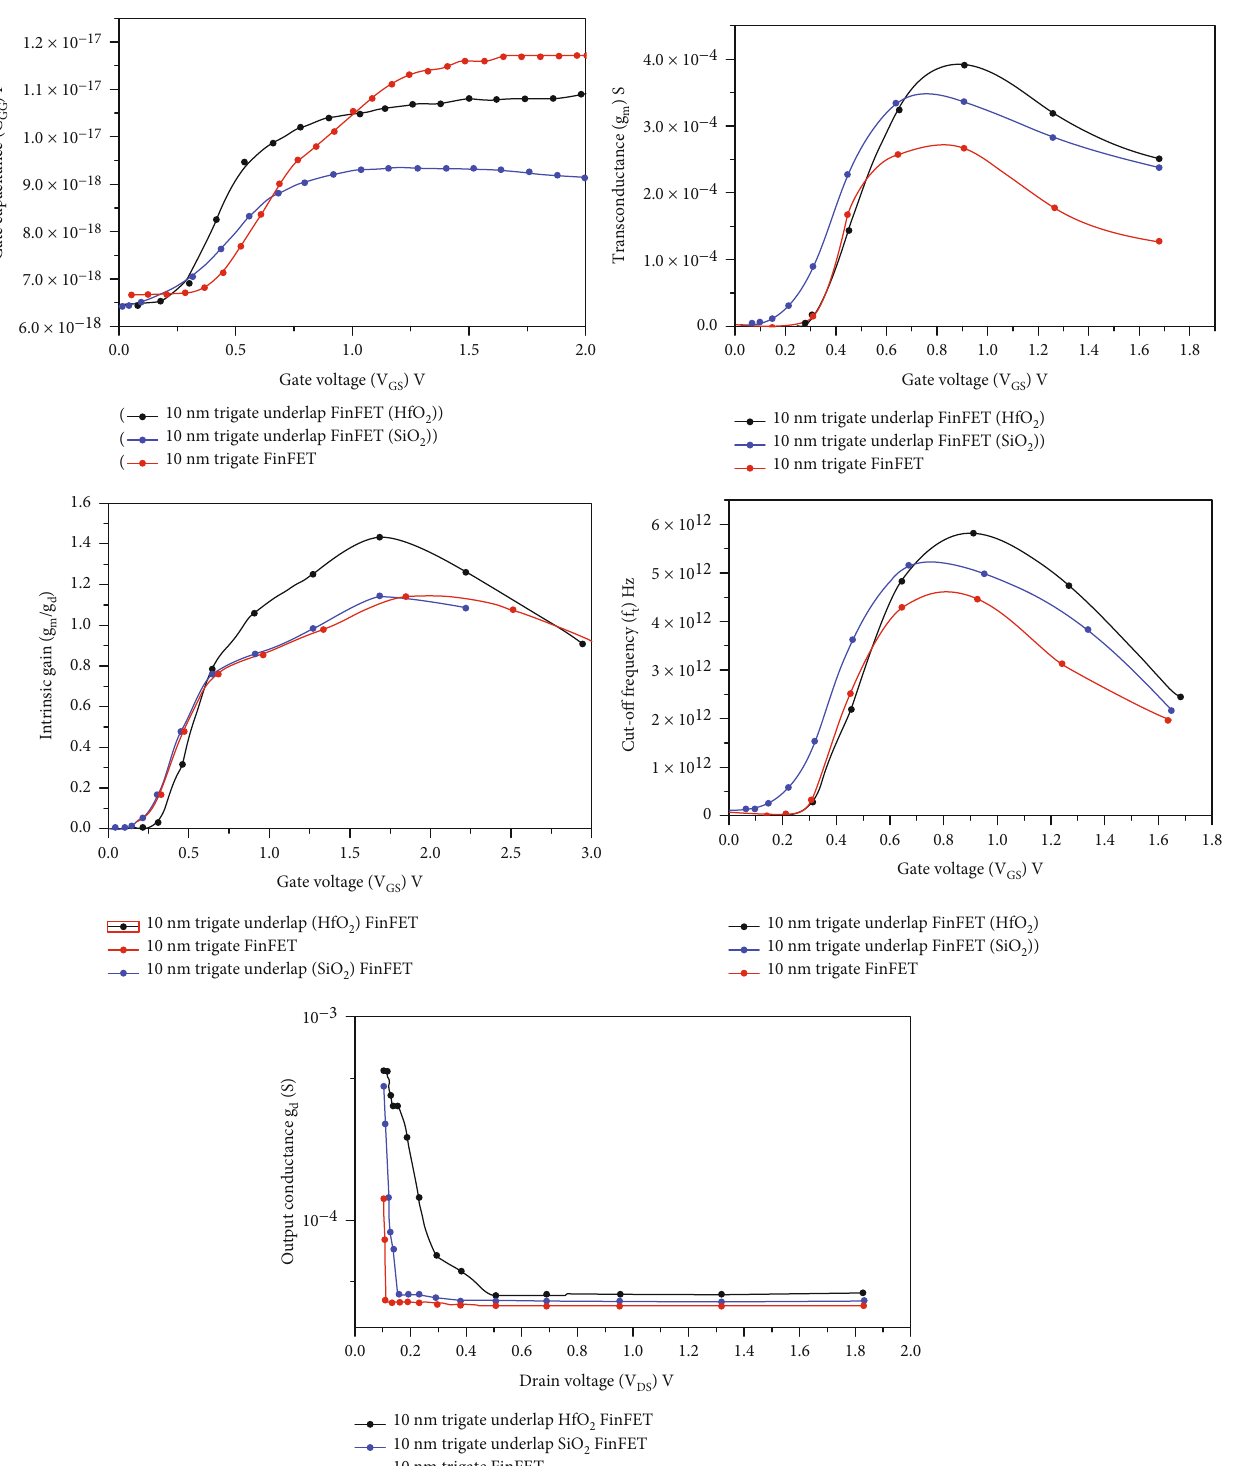
Figure 5: Performance analysis of the electrostatic control. But beyond 5 nm, it will not have FinFET device. The device ’ s performance is slowed by a high enough electrostatic control. threshold voltage, whereas a lower threshold voltage tends to Quantum mechanical (QM) con fi nement occurs across increase the OFF-state leakage current as illustrated in the channel of charge carriers in FinFET devices with a very Figure 3. FinFET of 10 nm will have enough electrostatic thin fi n thickness (10 nm). Both structural and electrical control because of su ffi cient gate length which provides good